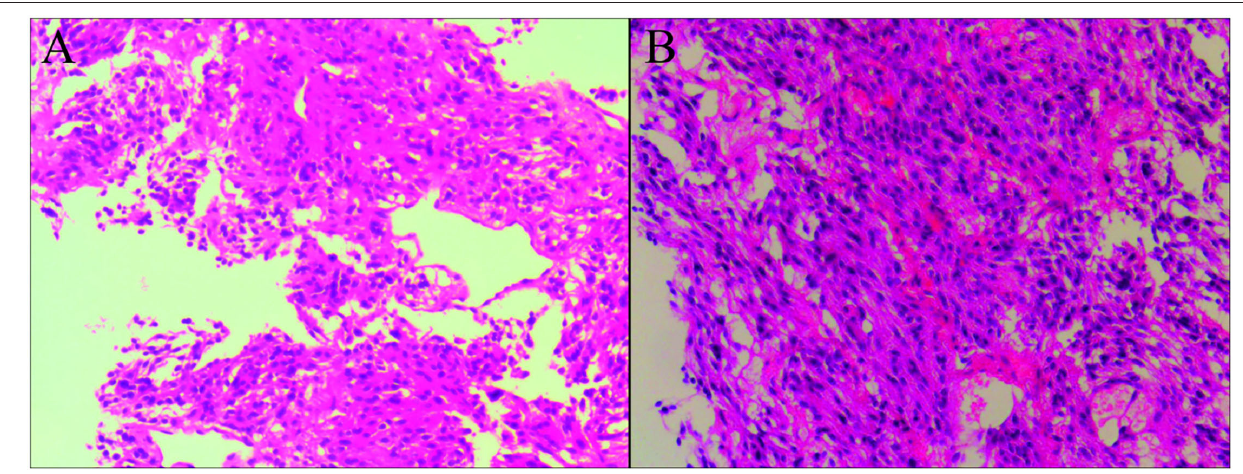
FIGURE 3 | Biopsies of the left ilium demonstrated the presence of metastasis of malignant pheochromocytoma. That tumor cells are spindle shaped and oval, with abundant cytoplasm and pink staining, and the nuclei are round, oval, and deeply stained, which are observed in the microscopic section of hematoxylin-eosin stain [ (A,B) , original magnification ×